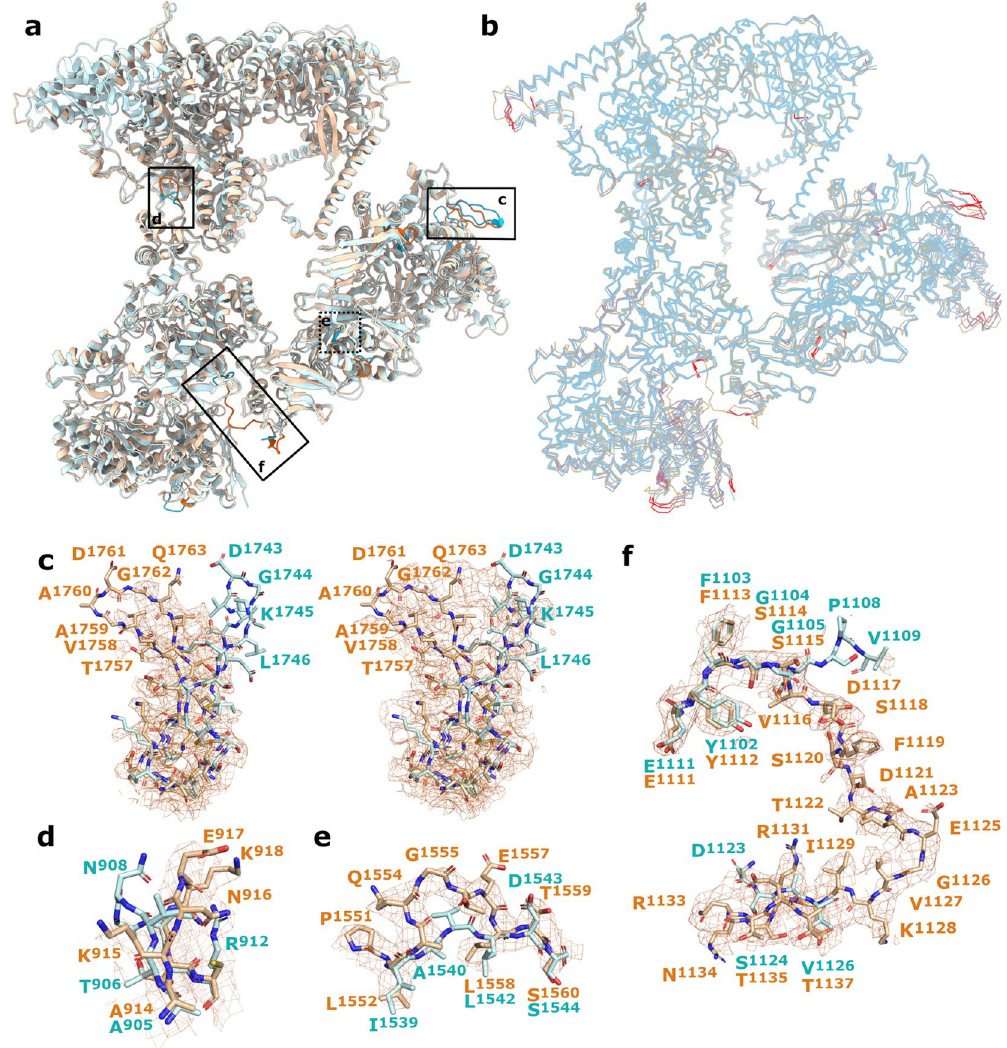
Figure 3. Unique structural features of P. pastoris FAS. ( a ) Overlay of P. pastoris FAS (orange) and S. cerevisiae FAS (PDB 6TA1, blue) from Joppe et al. (2020) 20 , with differences highlighted by stronger colours. Enlarged images are indicated on the map with boxes. ( b ) Wire representation of atomic model for P. pastoris FAS (orange) overlaid with a range of models of S. cerevisiae FAS (PDB 6TA1 20 , 6QL9 21 , 6QL6 21 , 2UV8 30 ; blue), with regions of high deviation (RMSD ≥ 15 Å) coloured red for S. cerevisiae FAS models. Segments of the backbone that were obviously misaligned (e.g., due to missing residues) were removed for clarity. ( c ) Loop region comprising residues 1753–1768, highlighting the different positioning compared to the equivalent region from S. cerevisiae FAS. The P. pastoris density map is overlaid at high contour level (left) and low contour level (right). ( d – f ) Other regions from different parts of the complex are highlighted and compared with equivalent regions of S. cerevisiae FAS, including the loop comprising residues 914–919 ( d ), the beta strand comprising residues 1553–1558 ( e ) and the additional resolved linking region comprising residues 1113–1135 ( f